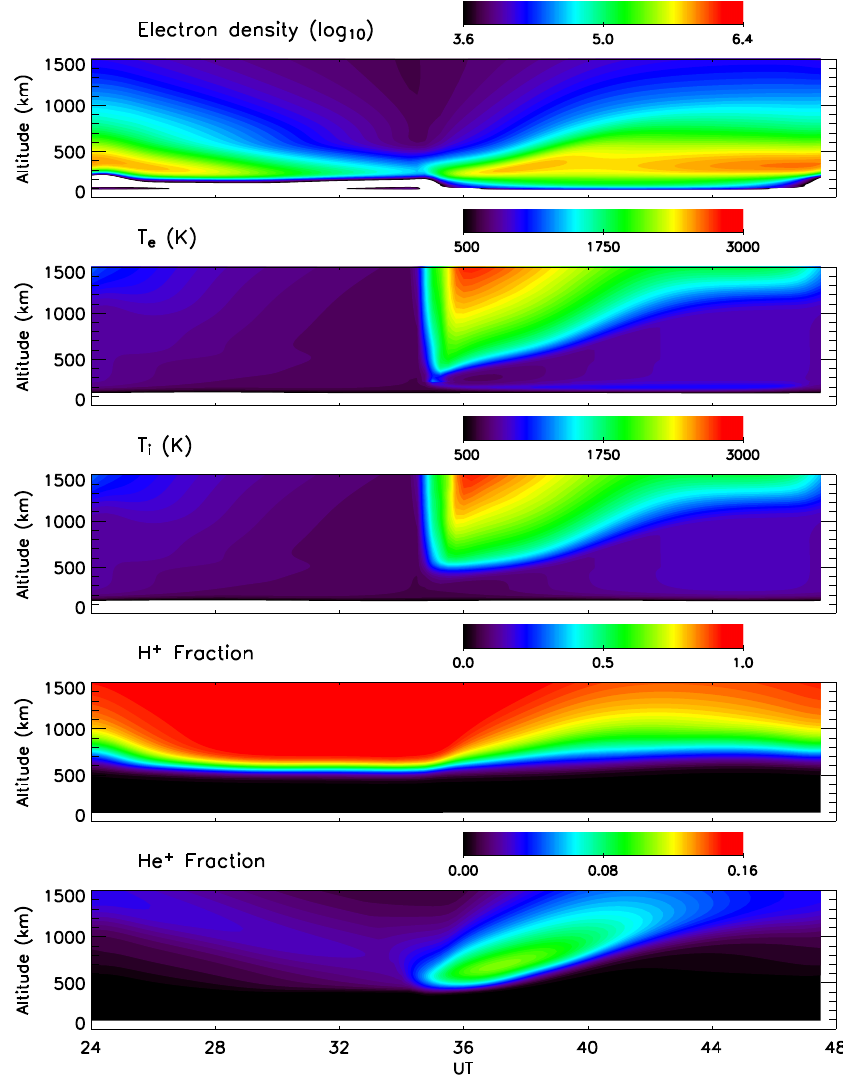
Fig. 8. SAMI2 model prediction for Jicamarca conditions, plotted in the same format as Figure 7.